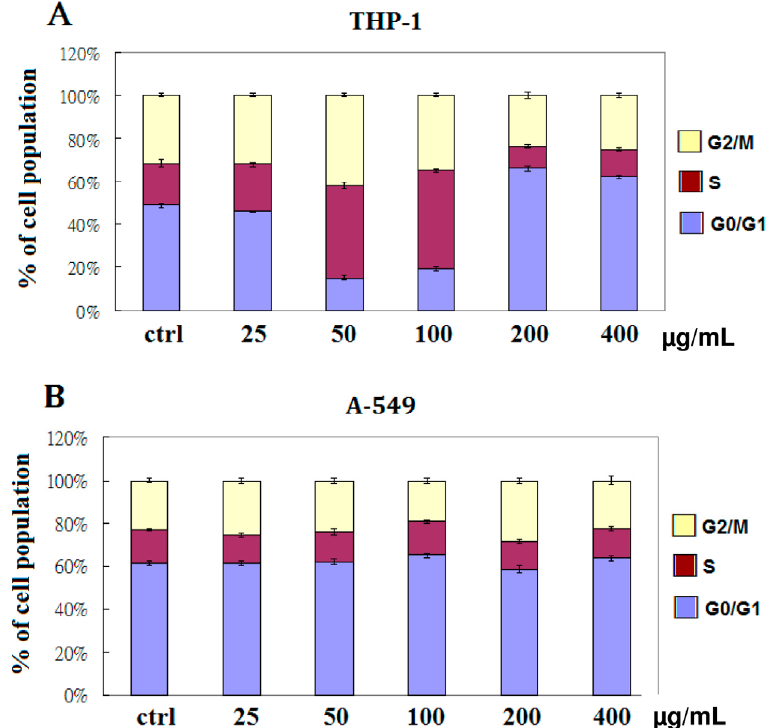
Figure 2. The effects of treatment with 25 μ g/mL, 50 μ g/mL, 100 μ g/mL, 200 μ g/mL, or 400 μ g/mL of EFW or distilled water (control) for 24 h on the cell cycle were analyzed by examining the DNA content by FACS of ( A ) THP-1 and ( B ) A-549 cells to determine the percentage of cells in G2/M phase (yellow), S phase (red), and G0/G1 phase (blue).